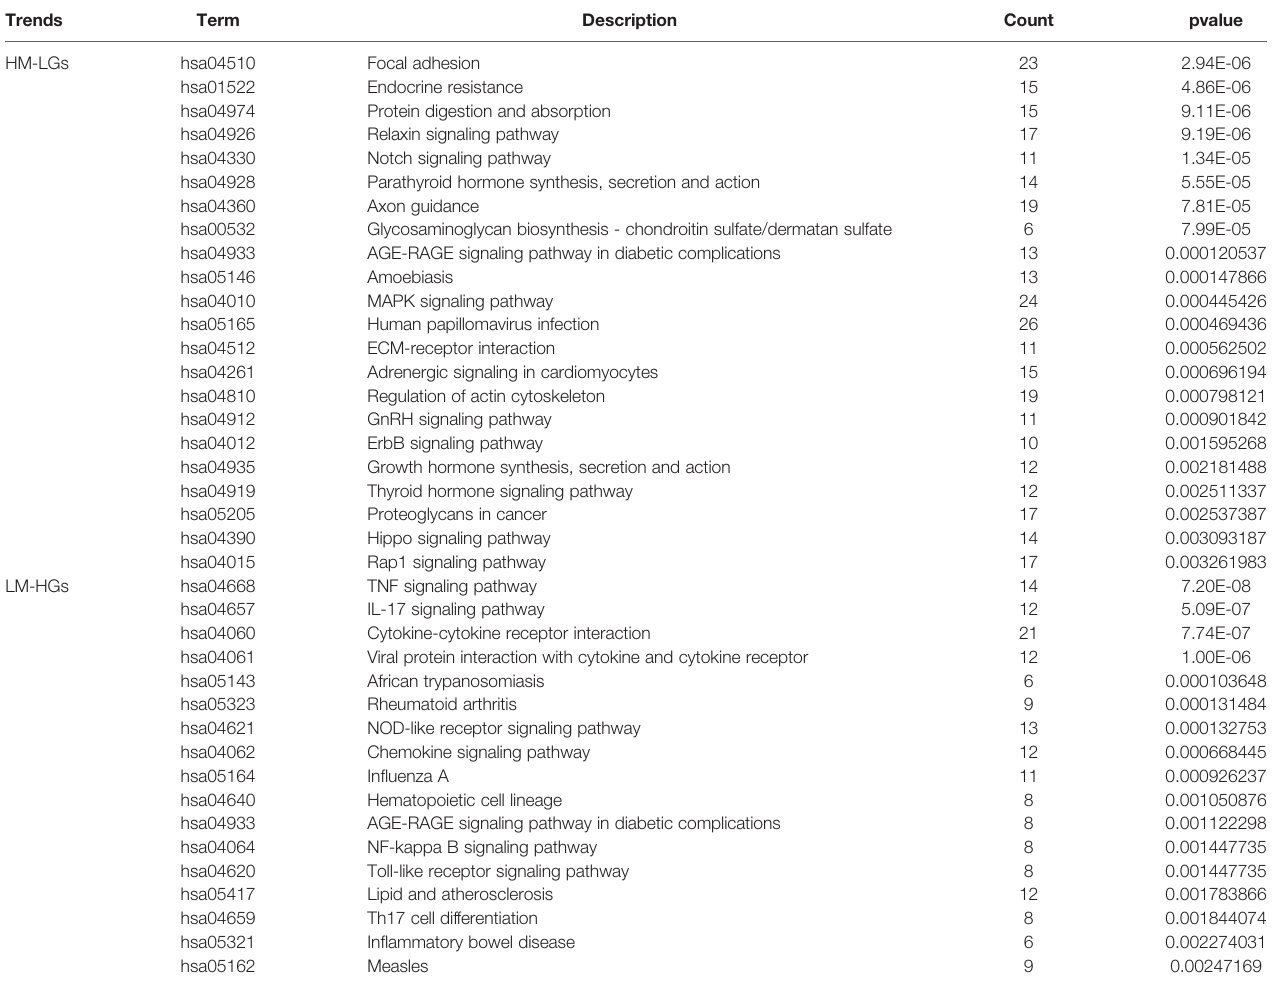
TABLE 2 | Functional enrichment analysis of miRNA regulatory networks.